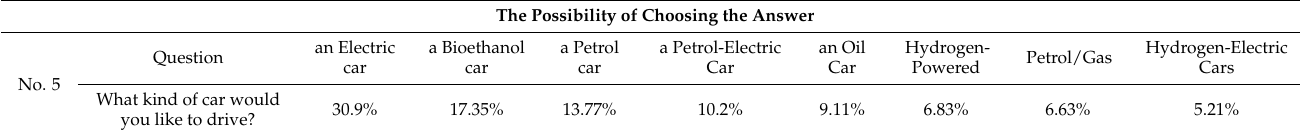
Table 5. Question no. 5, research results.